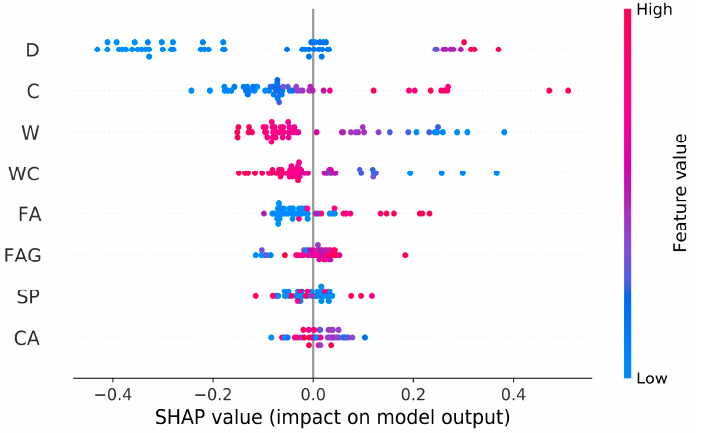
Figure 9. SHAP values in predicting the compressive strength of FAC.